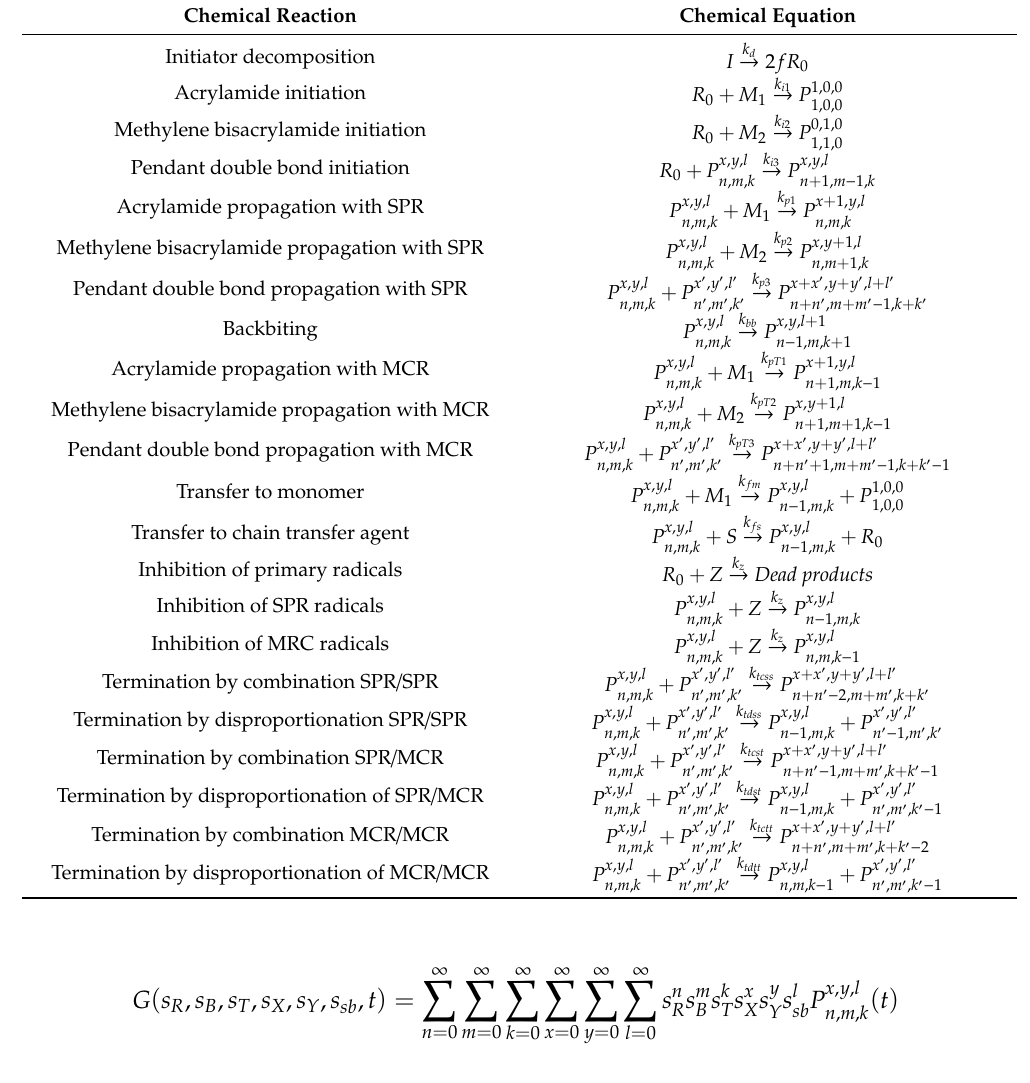
Table 3. Set of chemical reactions considered in kinetic modeling of the crosslinking polymerization of acrylamide (AAm) with methylene bisacrylamide